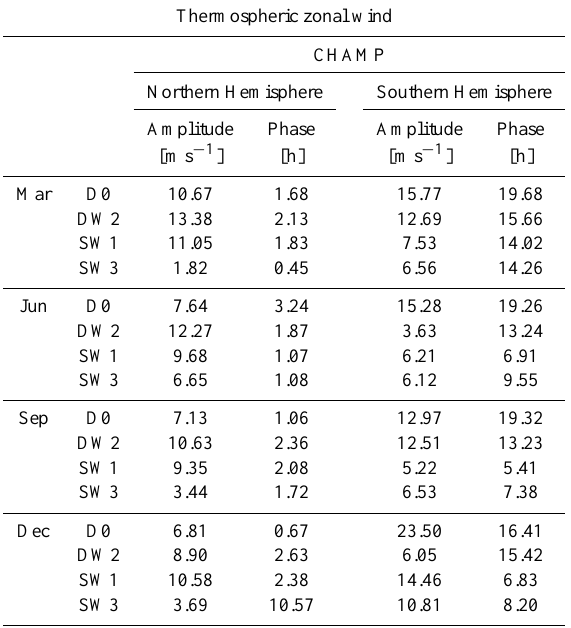
Table 2. Same as Table 1, but for the CHAMP zonal wind measure- ments during the years